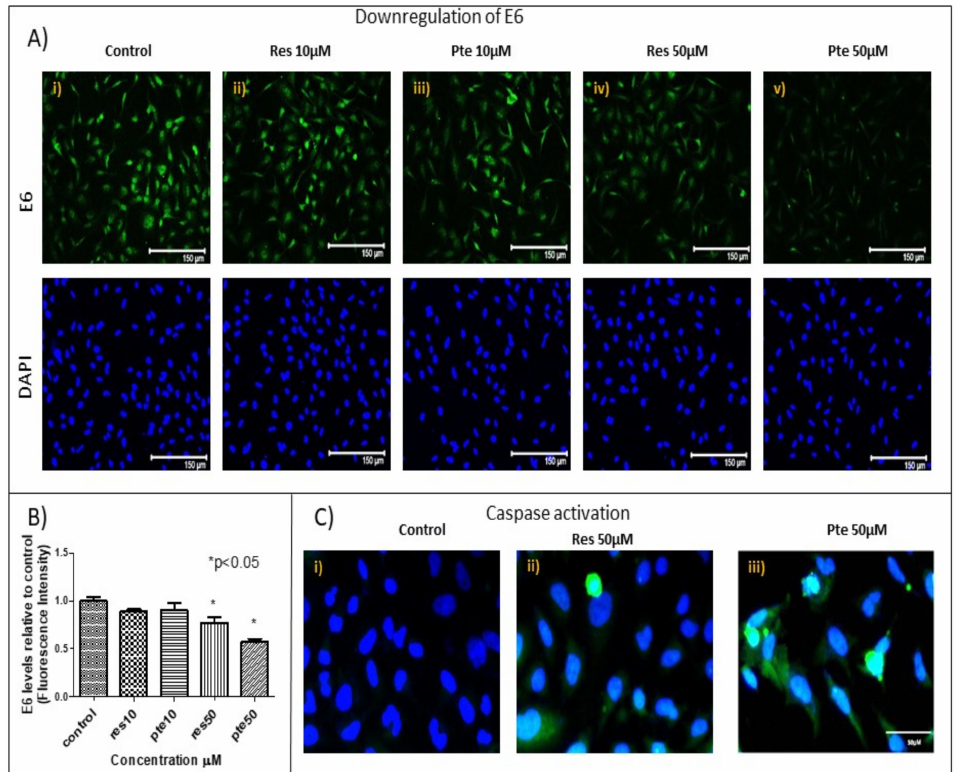
Figure 4. Downregulation of viral oncoprotein E6 and upregulation of active-caspase-3 in HeLa cells treated with resveratrol or pterostilbene: ( A ) HeLa cells immunostained for E6 levels (green) and counterstained with the nuclear dye 4’,6-diamidino-2-phenylindole (DAPI) (blue) after treatment with resveratrol (Res) and pterostilbene (Pte; 10 µ M and 50 µ M). Loss of E6 proteins are visually evident in cells treated with 50 µ M of either resveratrol or pterostilbene. ( B ) Cell image analysis of the E6 fluorescent data revealed a significant 43% decrease of E6 protein levels in HeLa cells treated with pterostilbene at 50 µ M and a 23% decrease of E6 levels in cells treated with resveratrol, both relative to the control. The graph represents data from experiments obtained from three independent experiments normalized to the control (mean % normalized to DAPI ± S.E.M.; * p < 0.05). ( C ) Immunofluorescent images probing for active-caspase-3 (green) shows a corresponding enhanced activation of this mediator of apoptosis by both resveratrol and